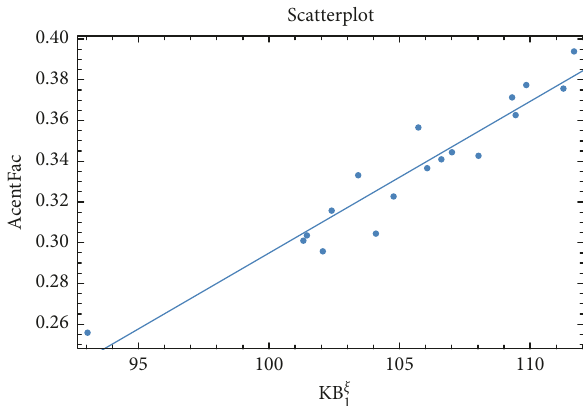
Figure 11: Scatter diagram of AcentFac on H the fitted regression